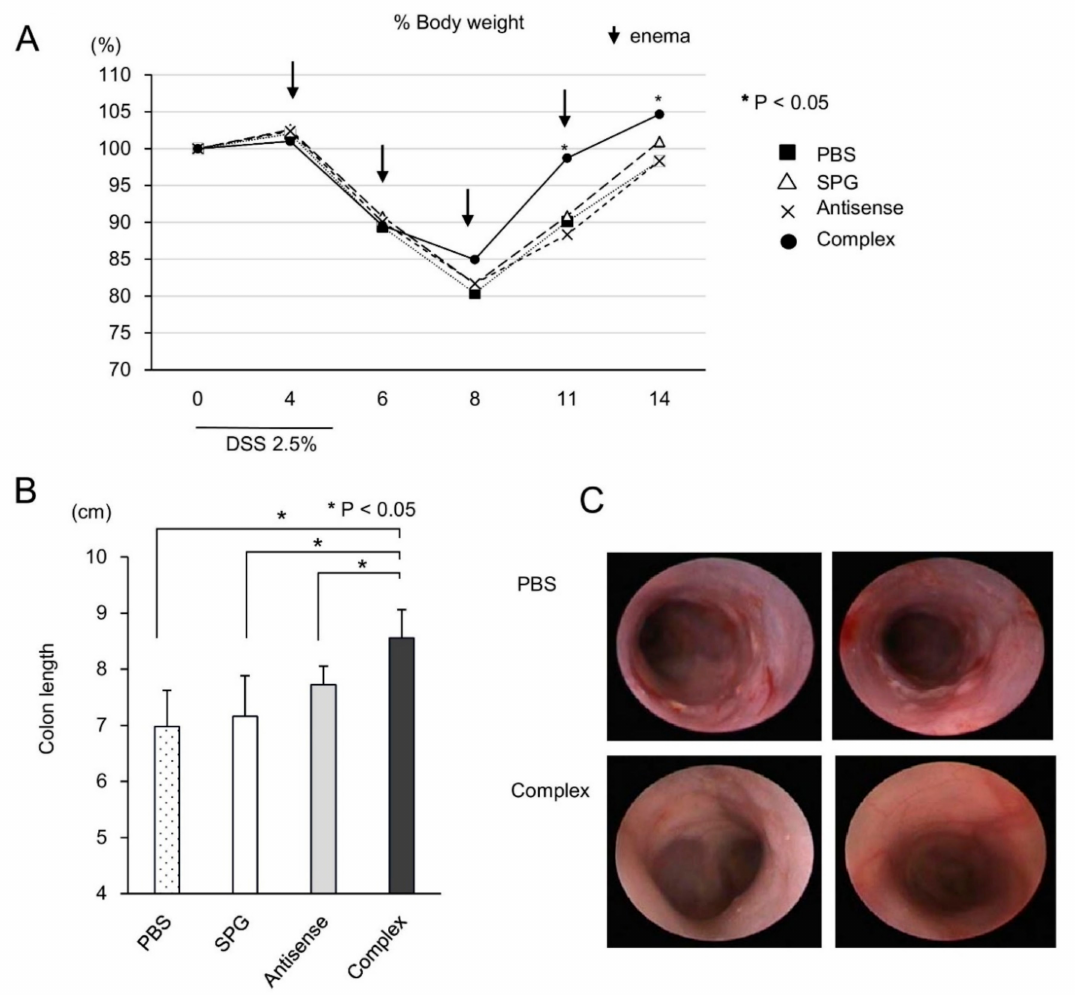
Figure 6. Attenuation of dextran sodium sulfate (DSS)-induced colitis via the administration of schizophyllan (SPG)-antisense tumor necrosis factor alpha (TNF- α ). A total of 0.2 mg / kg SPG-antisense TNF- α (complex), antisense TNF- α (antisense), SPG, and a phosphate bu ff er solution used as a control, were administered via enema twice weekly in mice receiving DSS ( n = 8 per group). ( A ) Body weights are presented as percentage of the initial weight on day 0. ( B ) The length of the colon from the terminal ileum to the rectum. ( C ) Endoscopic findings of the